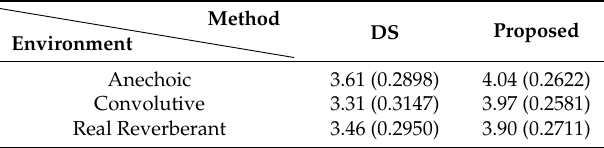
Table 3. Comparison of DMOS assessment results of the conventional and proposed methods for three different recording environments where the numbers in parentheses indicate 95%